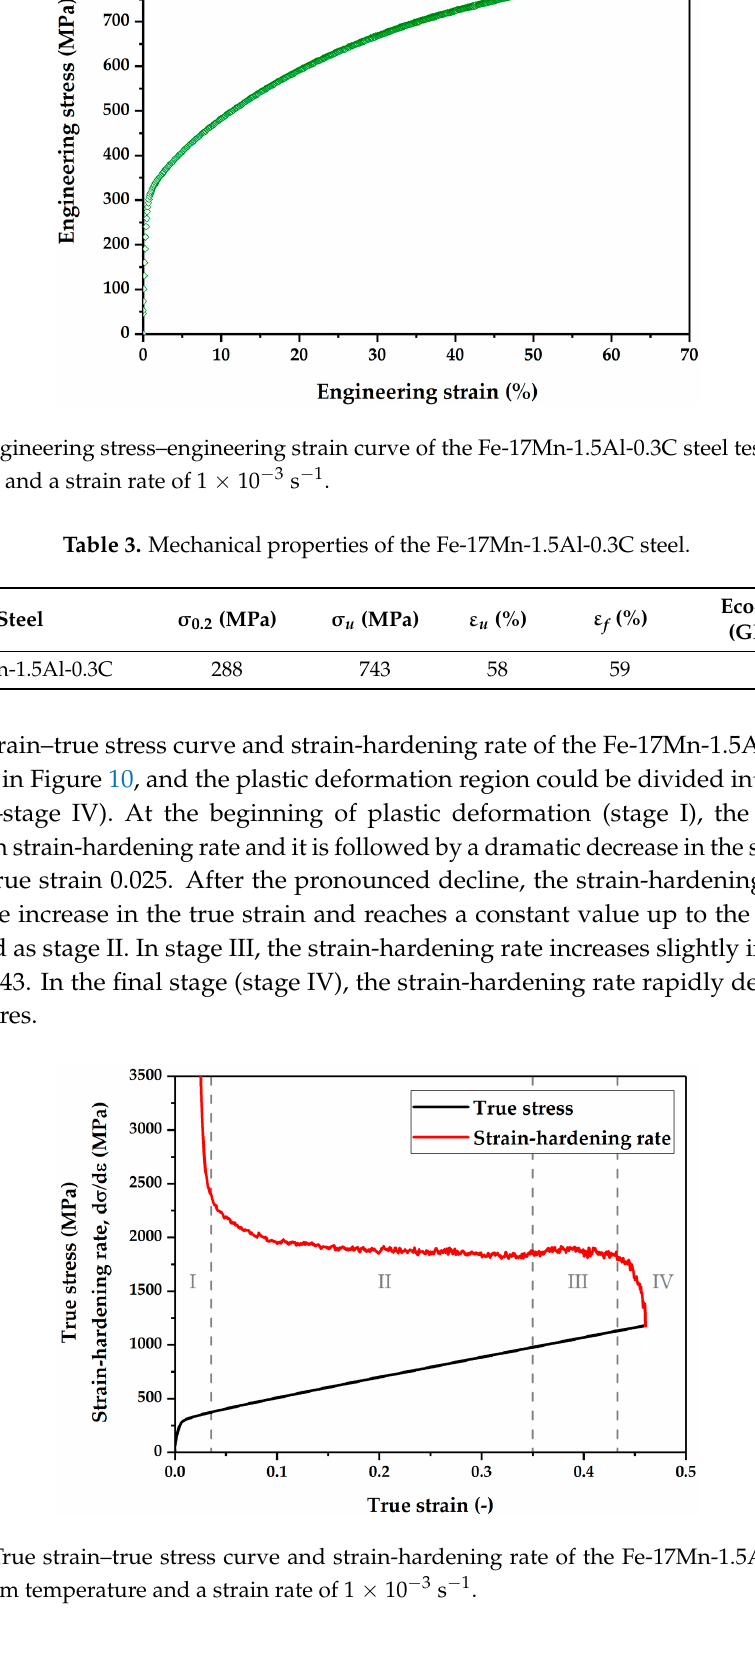
Figure 10. True strain–true stress curve and strain-hardening rate of the Fe-17Mn-1.5Al-0.3C steel tested at room temperature and a strain rate of 1 × 10 − 3 s − 1 .